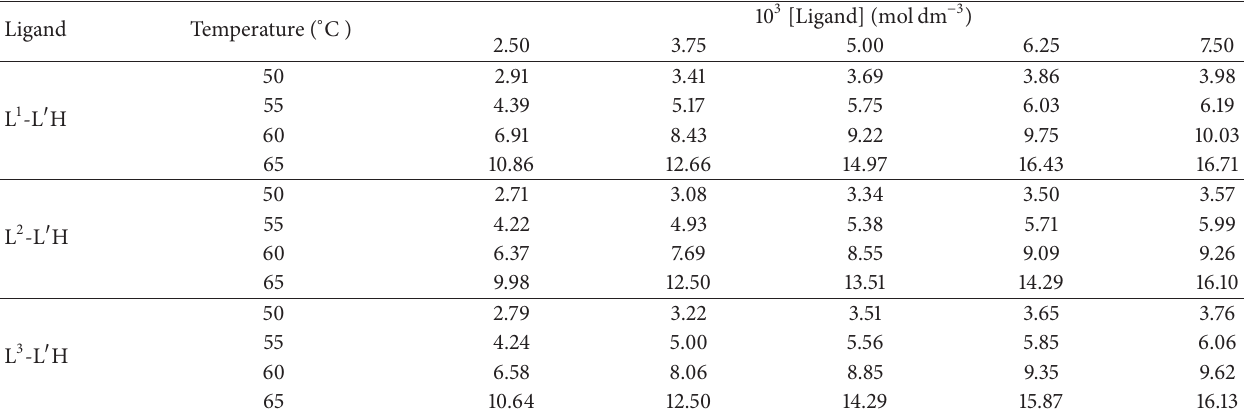
Table 2: 10 5 𝑘 2( (s − 1 ) values for different dipeptide concentrations at different temperatures; [Complex A ] = 2.5 × 10 − 4 moldm − 3 , pH = 4.3, obs ) . ionic strength = 0.1 moldm − 3 NaClO 4